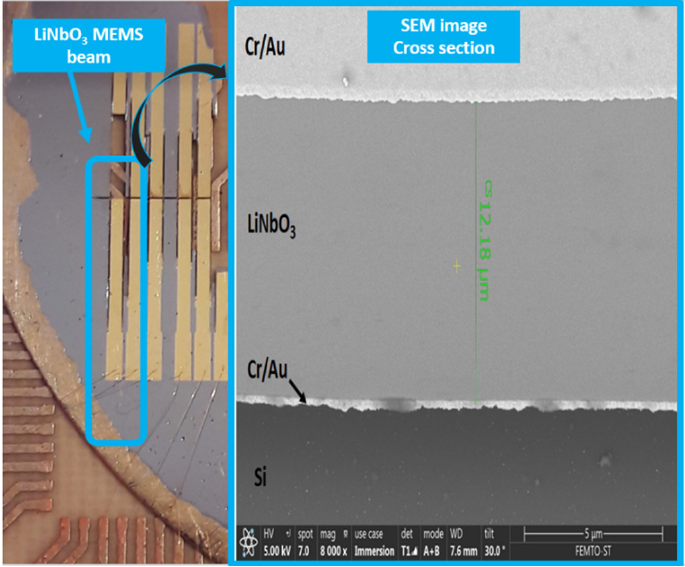
Figure 5. (YXlt)/163°/90° LiNbO 3- based MEMS energy converters with various lengths (on the left ) and cross-section of a realized device (on the right ).